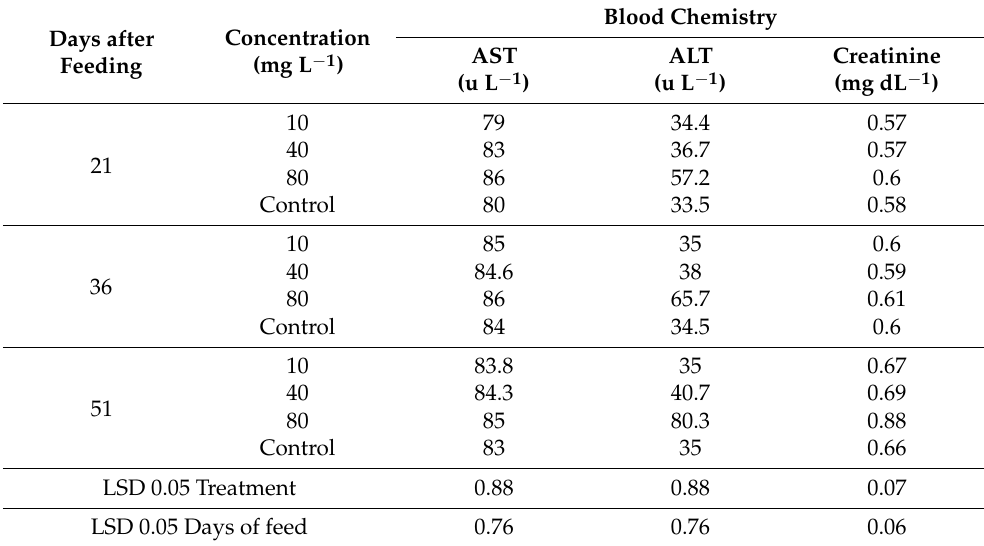
Table 9. Liver and kidney functions analysis of male albino rats fed on grain sorghum treated with Fe 3 O 4 /HA